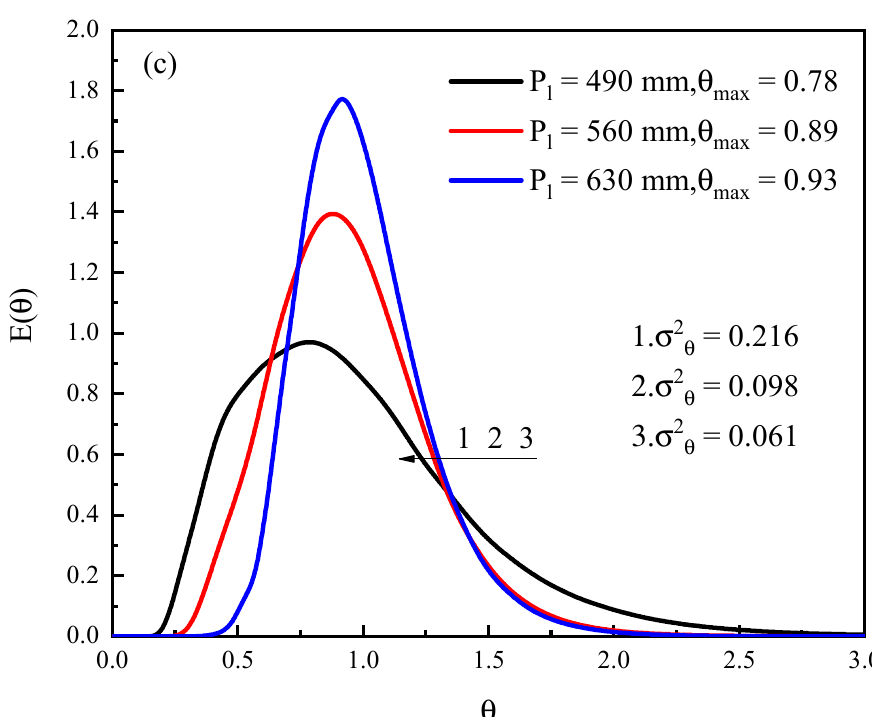
Figure 6. Plot of the effect of pole plate height on the RTD curve (( a ): The residence time distribution curves of the reactor when V is 2.6 m/s, P s is 172.6 mm, and P l is 490, 560 and 630 mm, respectively; ( b ): The residence time distribution curves of the reactor when V is 2.6 m/s, P s is 129.45 mm, and P l is 490, 560 and 630 mm, respectively; ( c ): The residence time distribution curves of the reactor when V is 2.6 m/s, P s is 103.56 mm, and P l is 490, 560 and 630 mm, respectively).